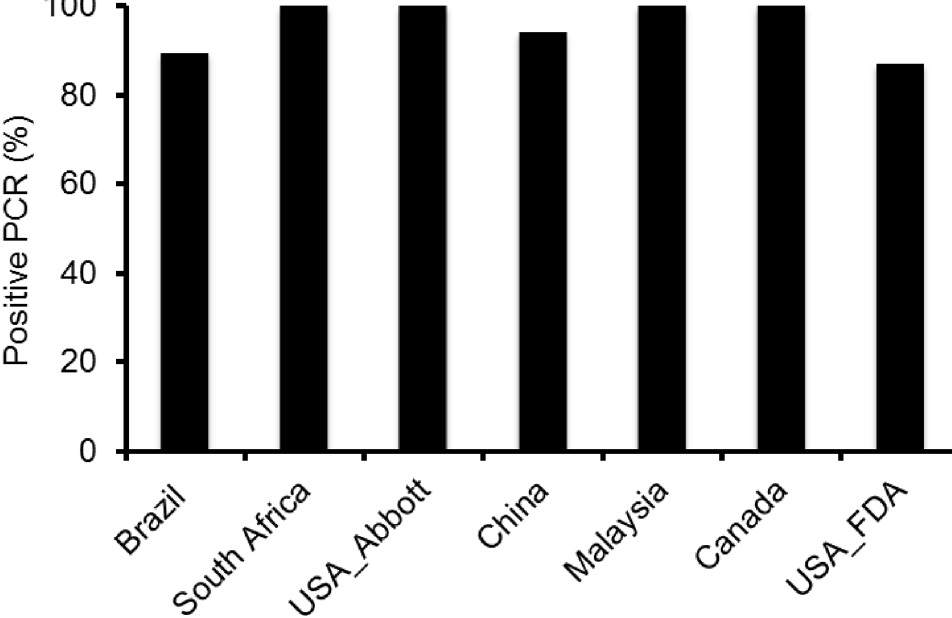
Fig 1. Comparison of PCR success rates. Partial pol genes were amplified for 47 group M viruses at six sites. The whole pol gene was amplified at the USA_FDA